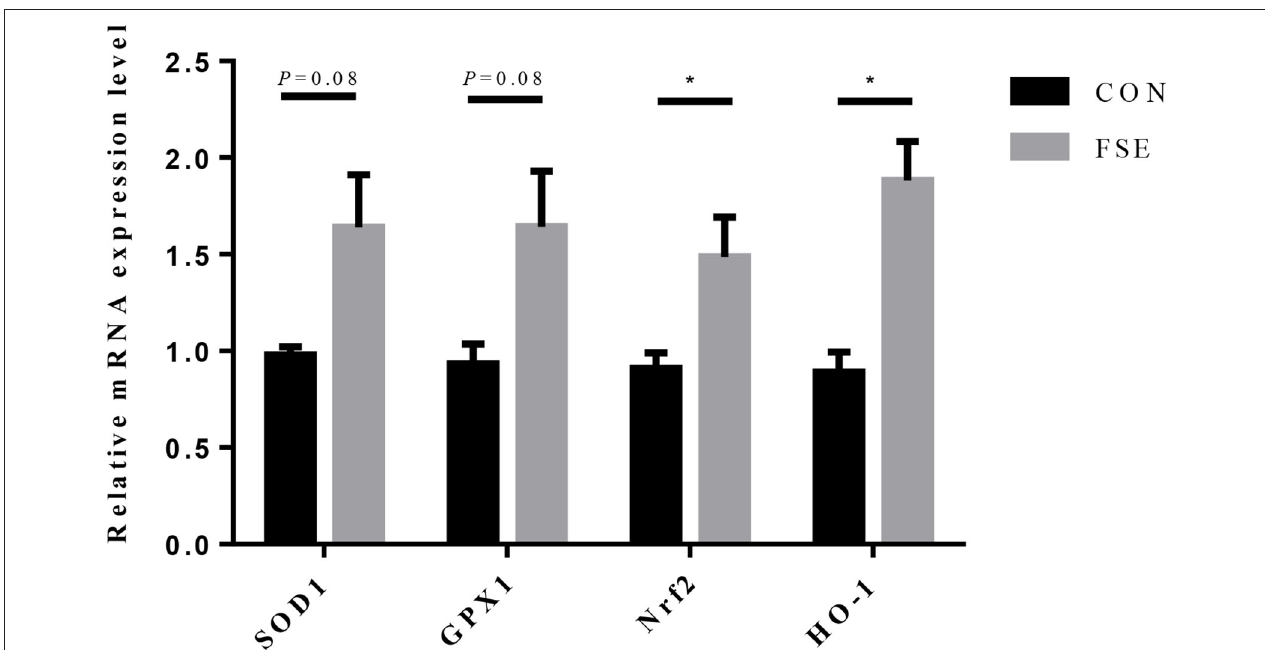
FIGURE 6 | Effects of maternal dietary Forsythia suspensa extract supplementation on relative mRNA expression of antioxidant genes in liver of suckling piglets. CON group, basal diet; FSE group, basal diet + 100 mg/kg Forsythia suspensa extract. All values are expressed as means ± SEM. * P < 0.05. n = 6.